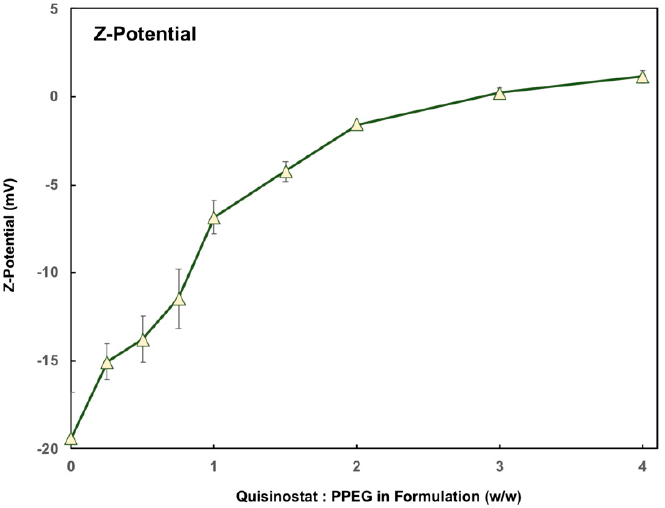
Figure A2. Z-potential measurements for PPEG–quisinostat formulations ( n = 3; error bars represent standard deviation).